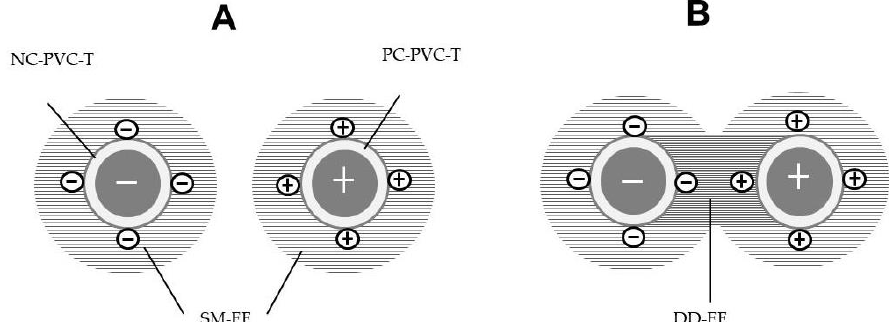
Figure 5. ( A ) Single-charged monopolar and ( B ) double-charged dipolar electric fields formed by negatively and positively electrified soft polyvinyl chloride tubes that were filled with oppositely charged water. Abbreviations: NC-PVC-T, negatively charged polyvinyl chloride tube; PC-PVC-T, positively charged polyvinyl chloride tube; SM-EF, single-charged monopolar electric field; DD-EF, double-charged dipolar electric field.